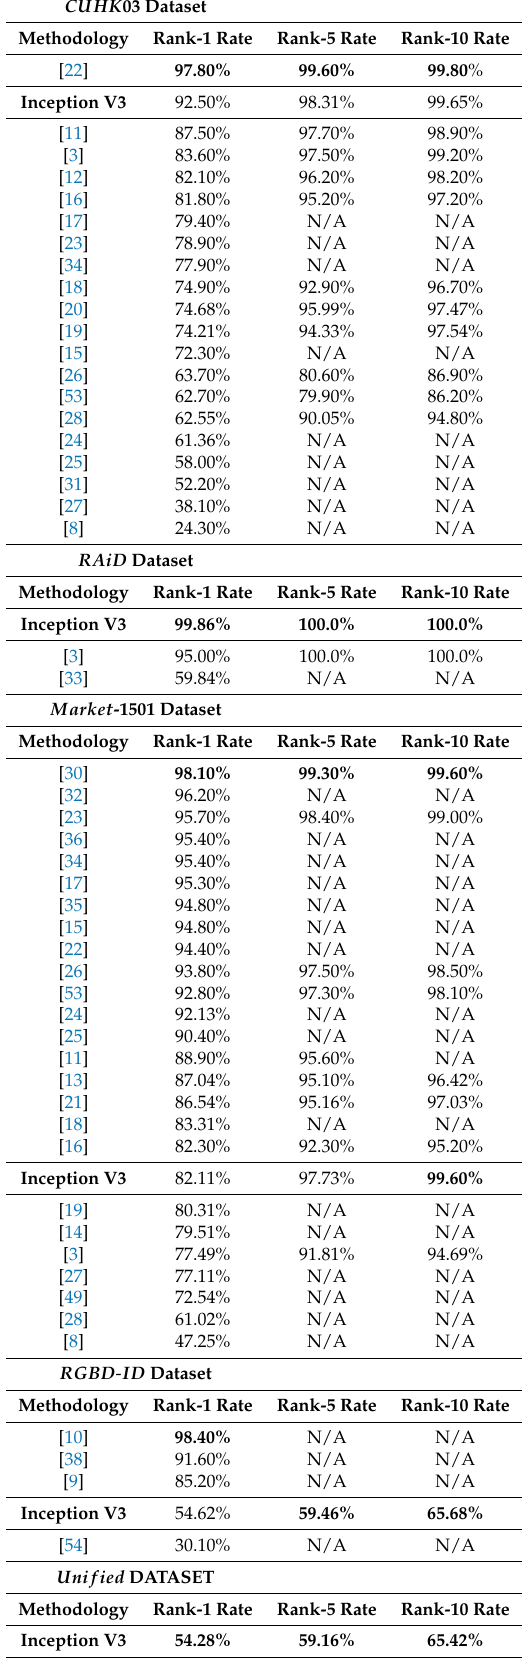
Table 3. Accuracy of the Inception V3 network at different ranks (Ranks-1, 5, 10), against state-of-the-art Re-Identification (Re-ID) methods, per dataset, for the identification